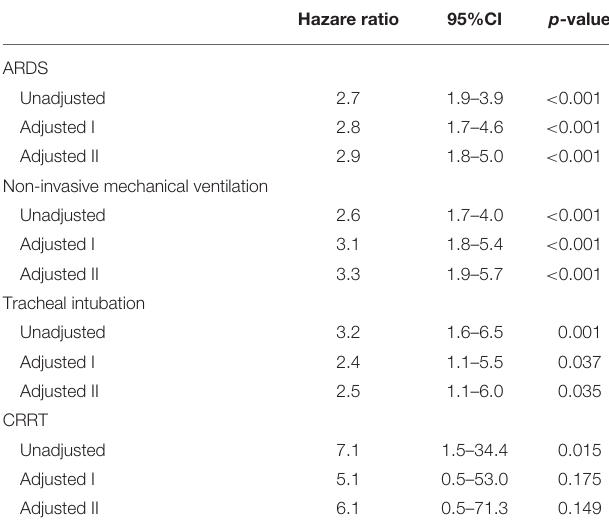
TABLE 5 | Univariate and multivariate analysis for non-invasive mechanical ventilation, tracheal intubation, CRRT, and ARDS in COVID-19 patients with GI